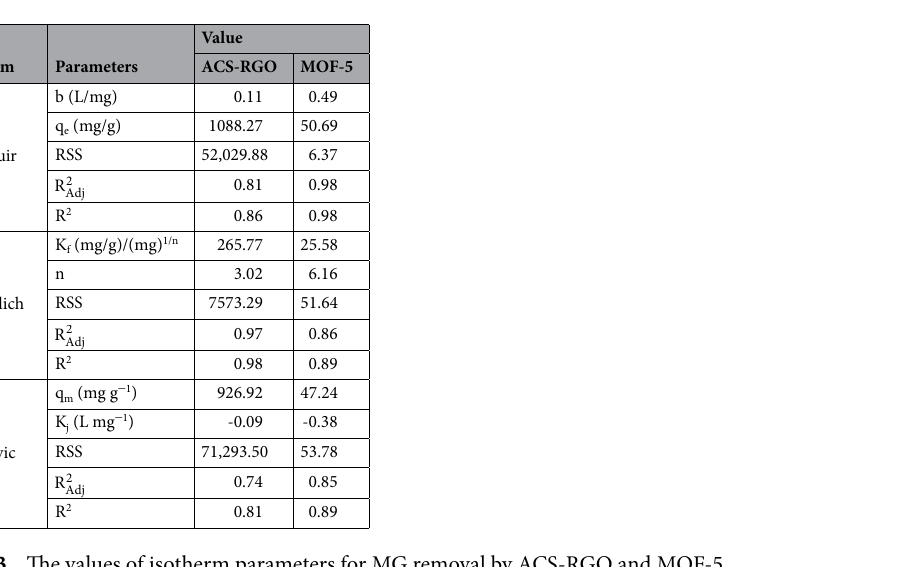
Table 3. The values of isotherm parameters for MG removal by ACS-RGO and MOF-5.